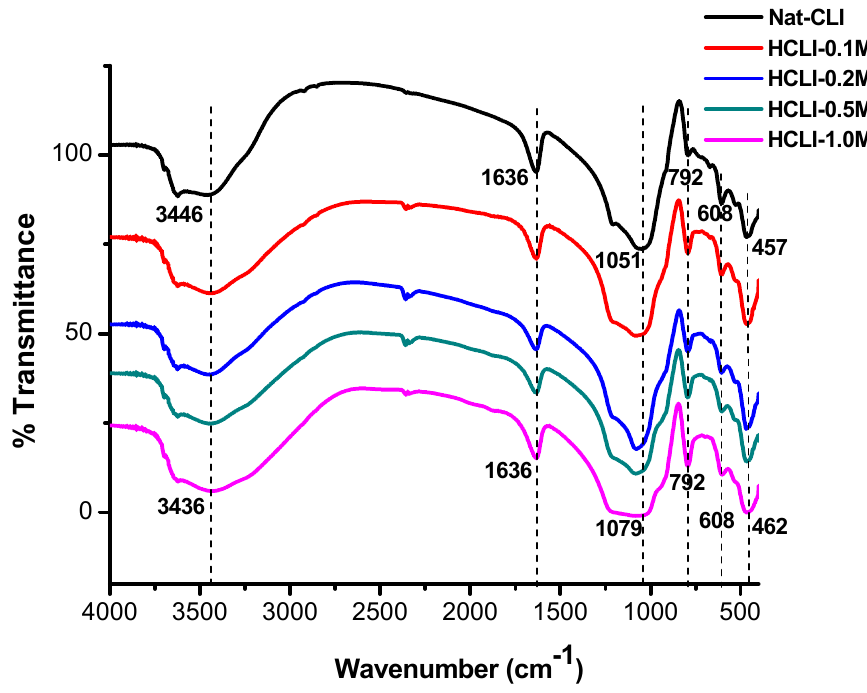
Figure 3. Fourier-transform infrared spectroscopy (FTIR) spectra of non- and acid-modified clinoptilolite-rich tuffs.